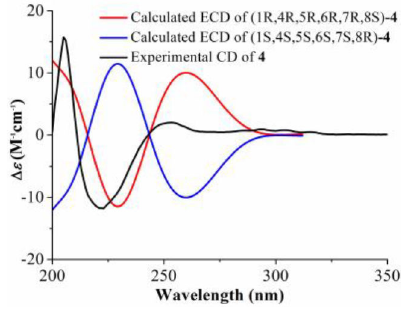
Figure 6. Calculated and experimental ECD spectra of compound